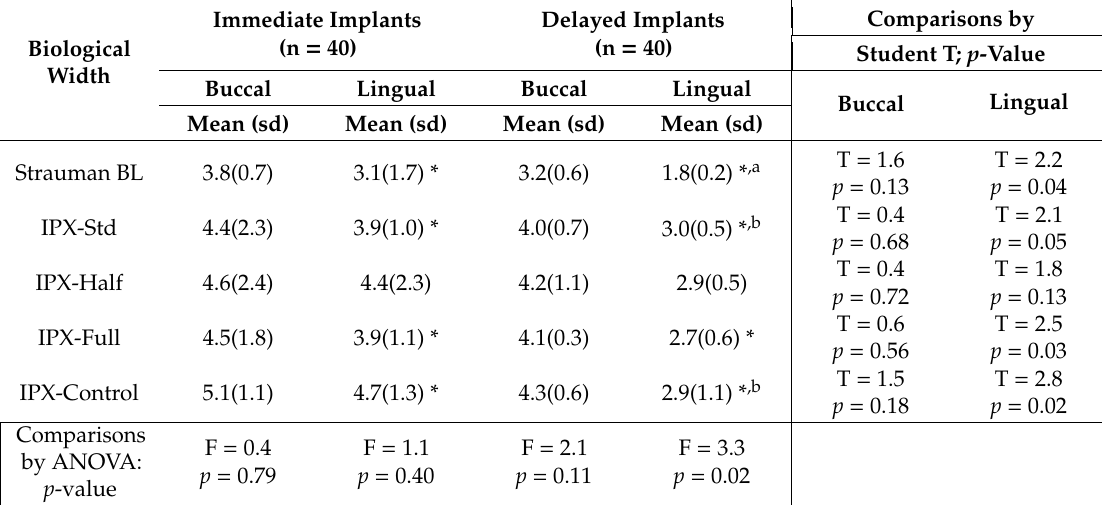
Table 2. Comparison of the biological width (the distance between PM and B) between deferred and immediate implants in both the buccal and lingual sides (mm) among the implant subgroups. * Statistically significant inter-group comparisons according to ANOVA test ( p < 0.05). The letters (a,b) next to the symbol * indicate the groups that are statistically di ff erent after Post Hoc Bonferroni correction.